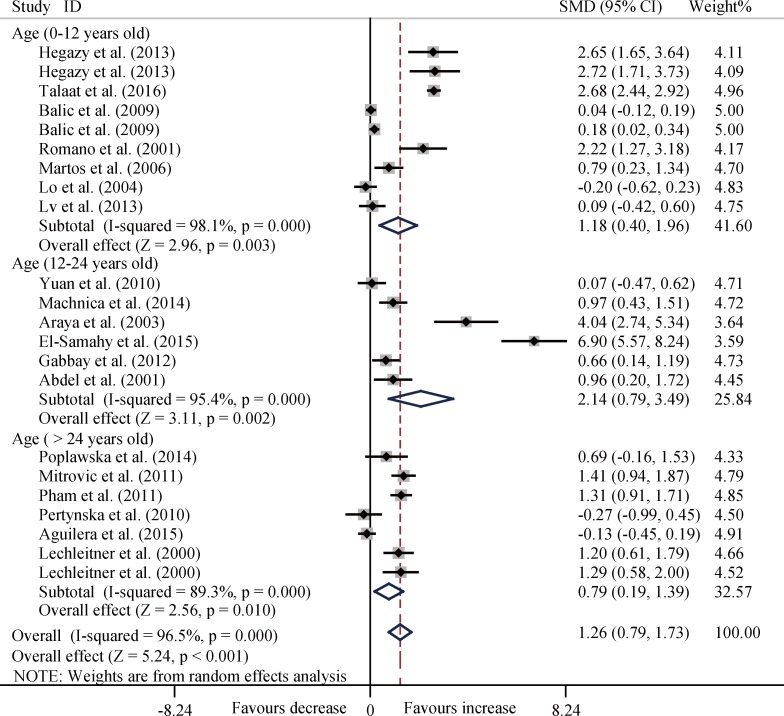
Forest plots about subgroup analysis for the level of TNF-α between T1DM patients and controls with random effects model among different age groups.Age, 0–12 years old, SMD, 1.18, 95% CI, 0.40 to 1.96, P = 0.003; Age, 12–24 years old, SMD, 2.14, 95% CI, 0.79 to 3.49, P = 0.002; Age, > 24 years old: SMD, 0.79, 95% CI, 0.19 to 1.39, P = 0.010; Overall, SMD, 1.26, 95% CI, 0.79 to 1.73, P < 0.001.